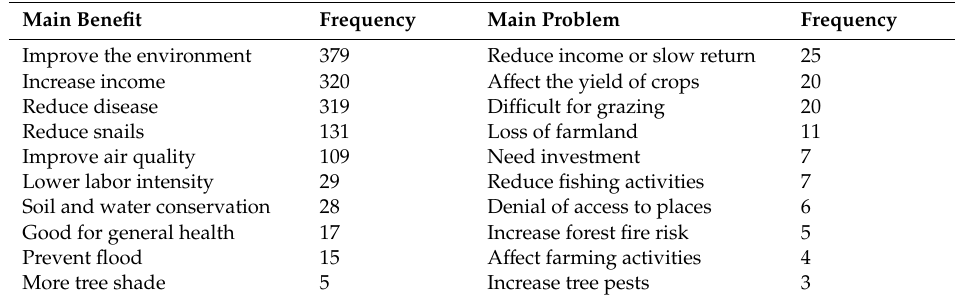
Table 5. Top ten benefits and problems caused by the planting programs according to the